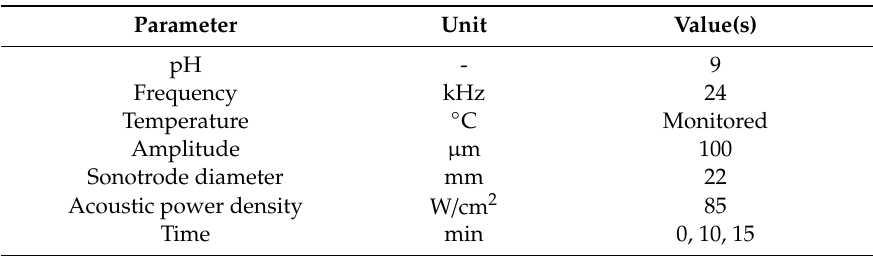
Figure 2. Procedure for alkaline extraction of flour lupine’s proteins assisted with ultrasound and acid precipitation. Table 1. Experimental parameters used for alkaline protein extraction assisted with ultrasound using Lupinus flours as raw material.